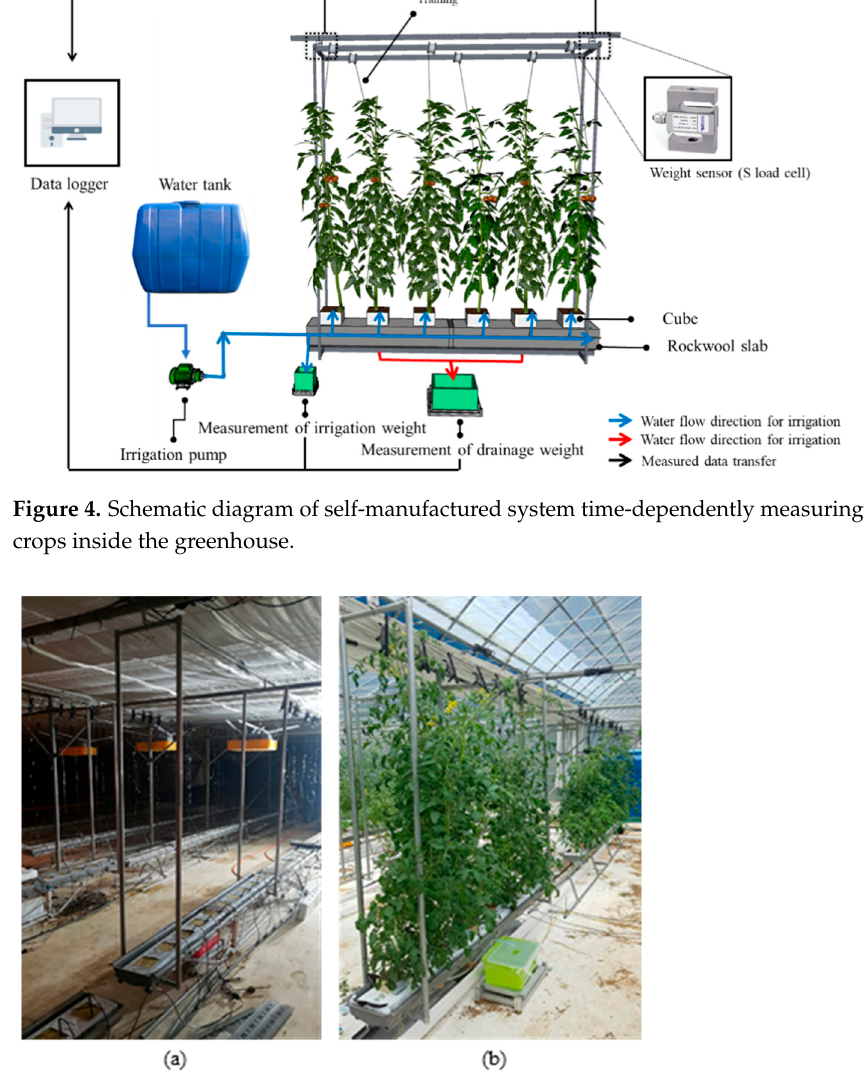
Figure 5. A monitoring device for the amount of evaporation used in greenhouses: ( a ) design process and ( b ) growing tomatoes.